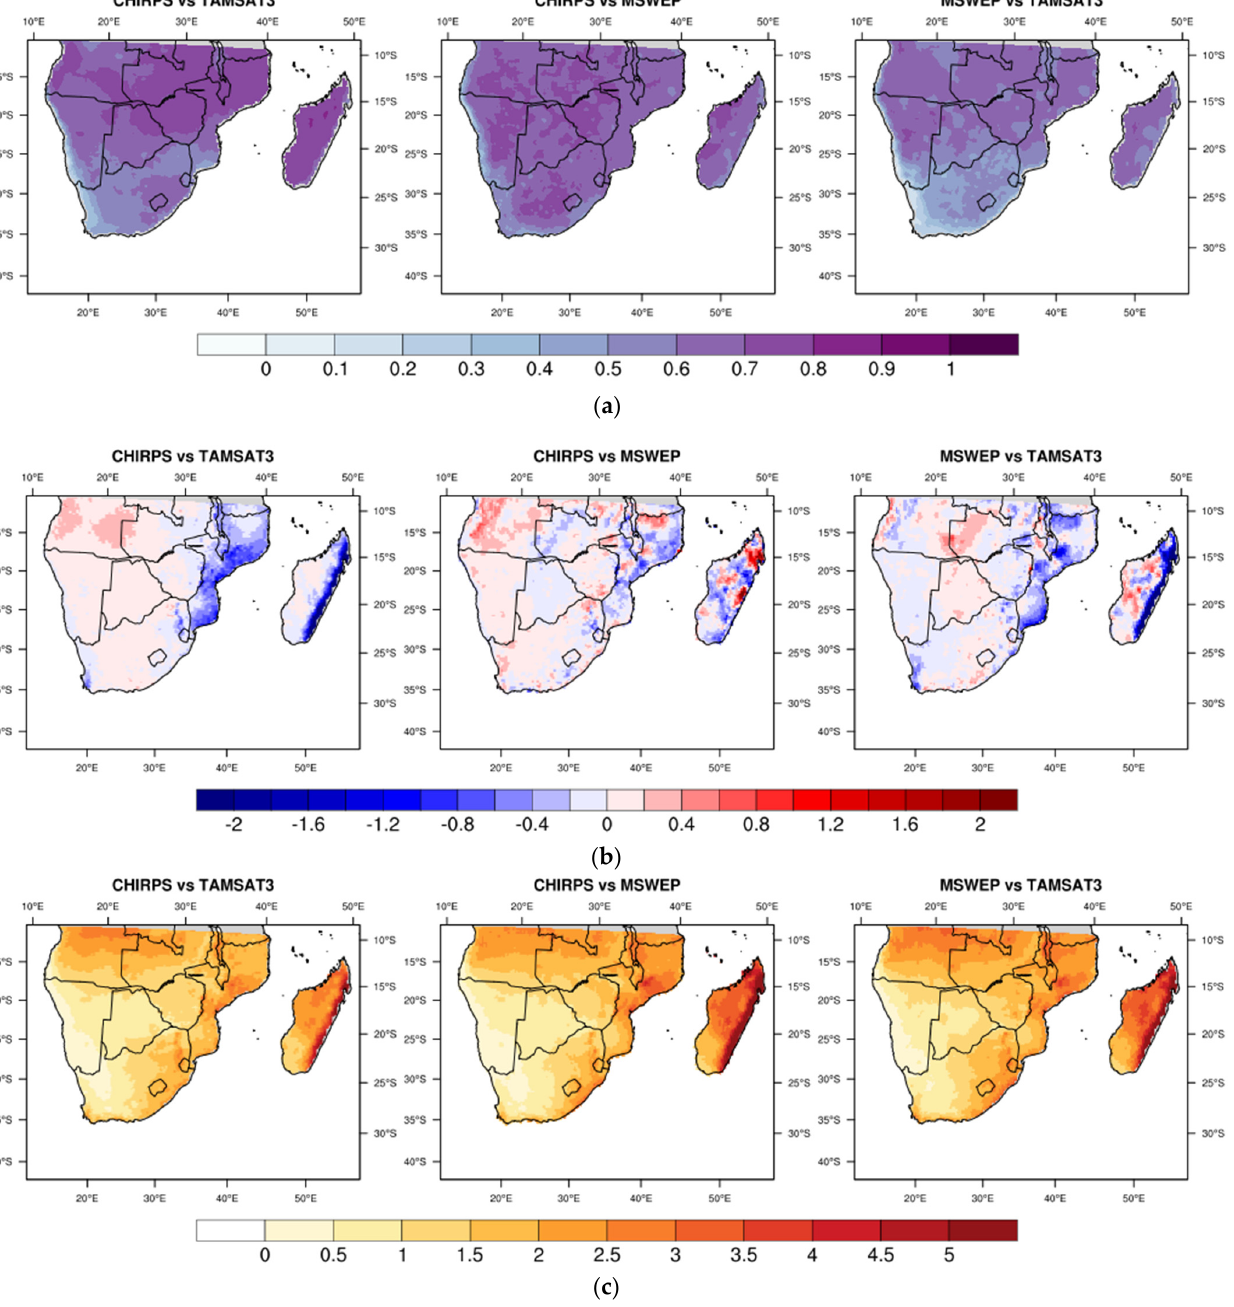
Figure 14. Maps of CC ( a ), ME (mm day –1 ) ( b ) and MAE (mm day –1 ) ( c ) for SA. Table 6. CC, ME and MAE spatially averaged over SA, with corresponding standard deviations.